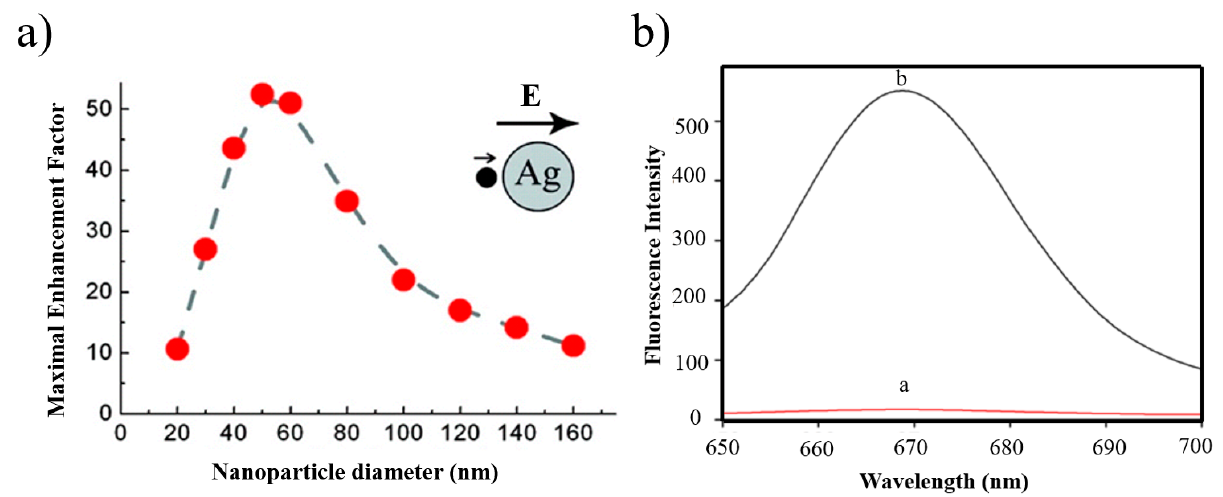
Figure 29. ( a ) The relationship between the fluorescence enhancement factor and the NPs’ diameter. The emission wavelength is 530 nm [119]. ( b ) Typical fluorescence spectra of a nanoflare (curve a) and control sample (curve b) [120].